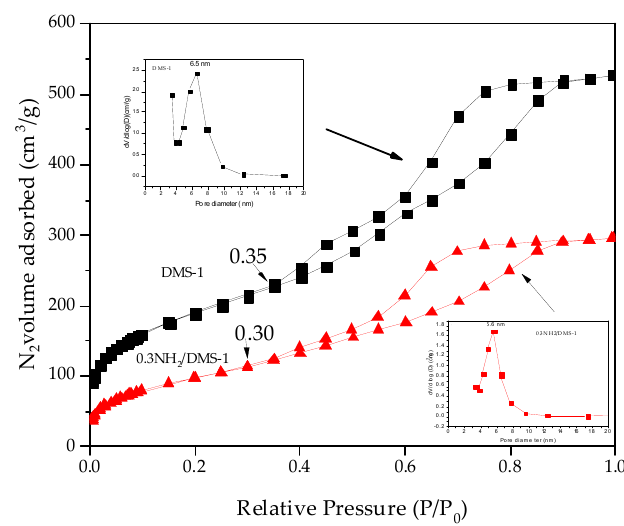
Figure 1. Nitrogen adsorption-desorption isotherm data of Disordered Mesoporous Silica 1 (DMS-1) adsorbent before functionalization and after functionalization with amines. Left insert: pore size distribution for DMS-1 material. Right insert: pore size distribution for amino-functionalized 0.3NH 2 / DMS-1 material. Table 1. Textural properties a of calcined DMS ‐ 1 before and after functionalization with NH 2 groups